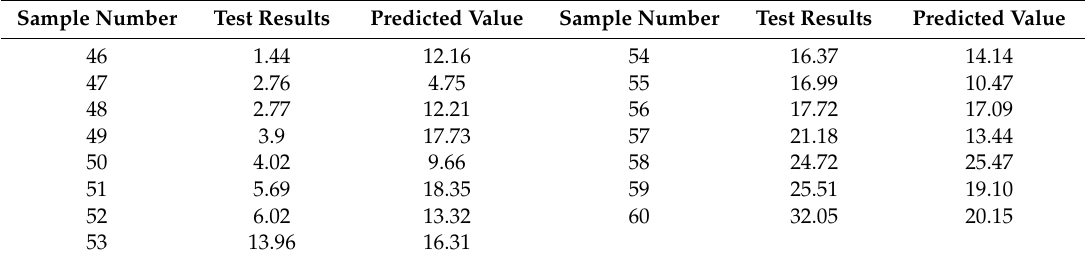
Table 3. Test values and predicted values of fixed carbon for the validation samples.